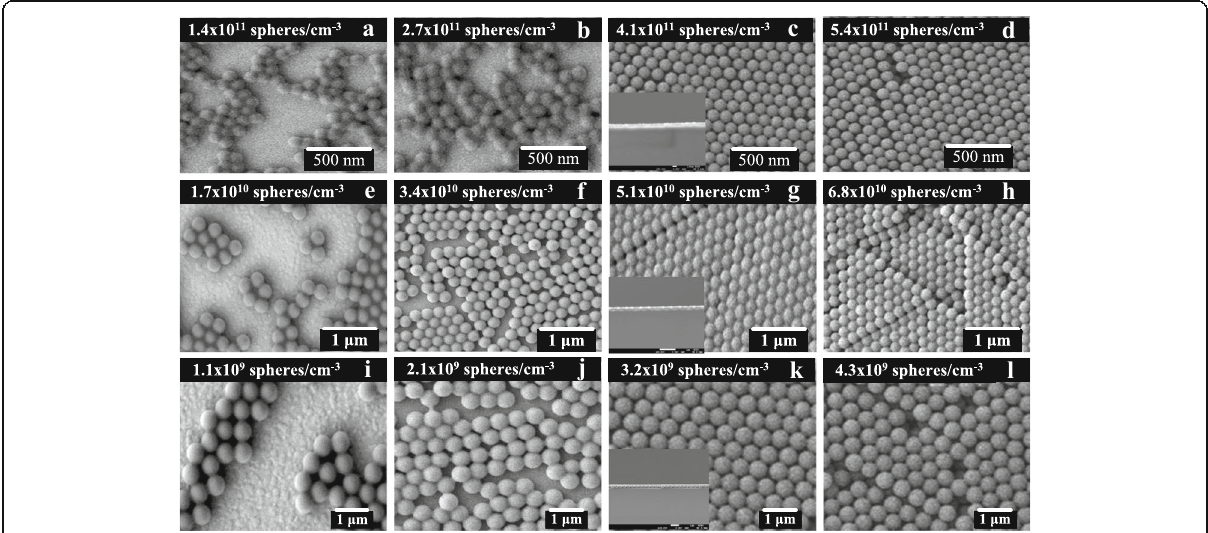
Fig. 3 SEM images of PS NSs with PS NS suspension concentrations of a 1.4 × 10 11 , b 2.7 × 10 11 , c 4.1 × 10 11 , and d 5.4 × 10 11 sphere/cm − 3 for 100-nm PS NSs; e 1.7 × 10 10 , f 3.4 × 10 10 , g 5.1 × 10 10 , and h 6.8 × 10 10 sphere/cm − 3 for 200-nm PS NSs; and i 1.1 × 10 9 , j 2.1 × 10 9 , k 3.2 × 10 9 , and l 4.3 × 10 9 sphere/cm − 3 for 500-nm PS NSs at an average dip-drop speed of 0.005 mL/s. The insets of c , g, and k represent the cross-section SEM images of PS NSs with PS NS suspension concentrations of 4.1 × 10 11 sphere/cm − 3 for 100-nm PS NSs, 5.1 × 10 10 sphere/cm − 3 for 200-nm PS NSs, and 3.2 × 10 9 sphere/cm − 3 for 500-nm PS